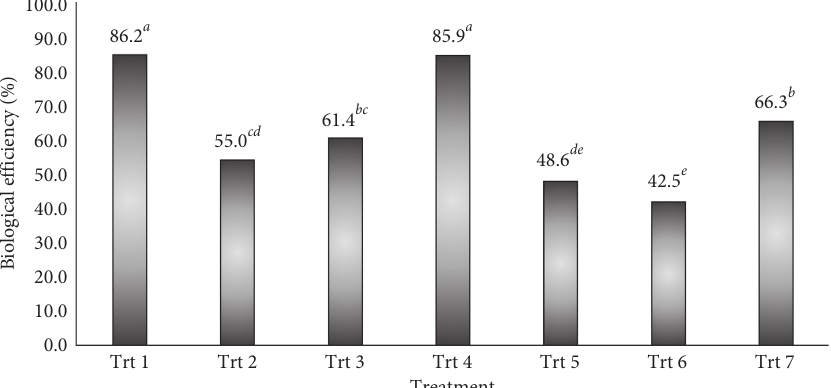
Figure 3: Graph showing the average biological efficiency of different substrate combinations used in the production of